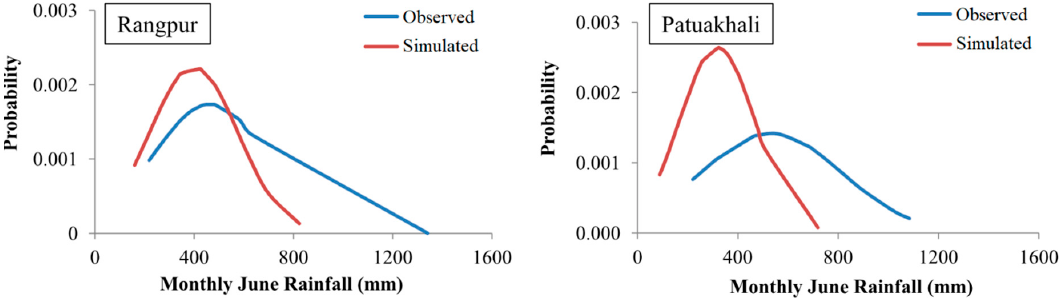
Figure 4. Comparison of probability density functions between observed and simulated June rainfalls at Rangpur ( left ) and Patuakhali ( right ) during the base period (1986–2005).